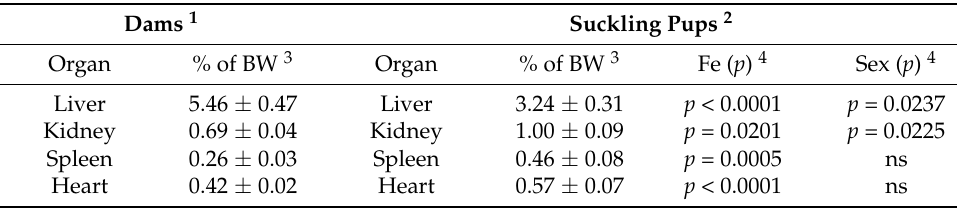
Table 4. Organ weights in experiment 1.